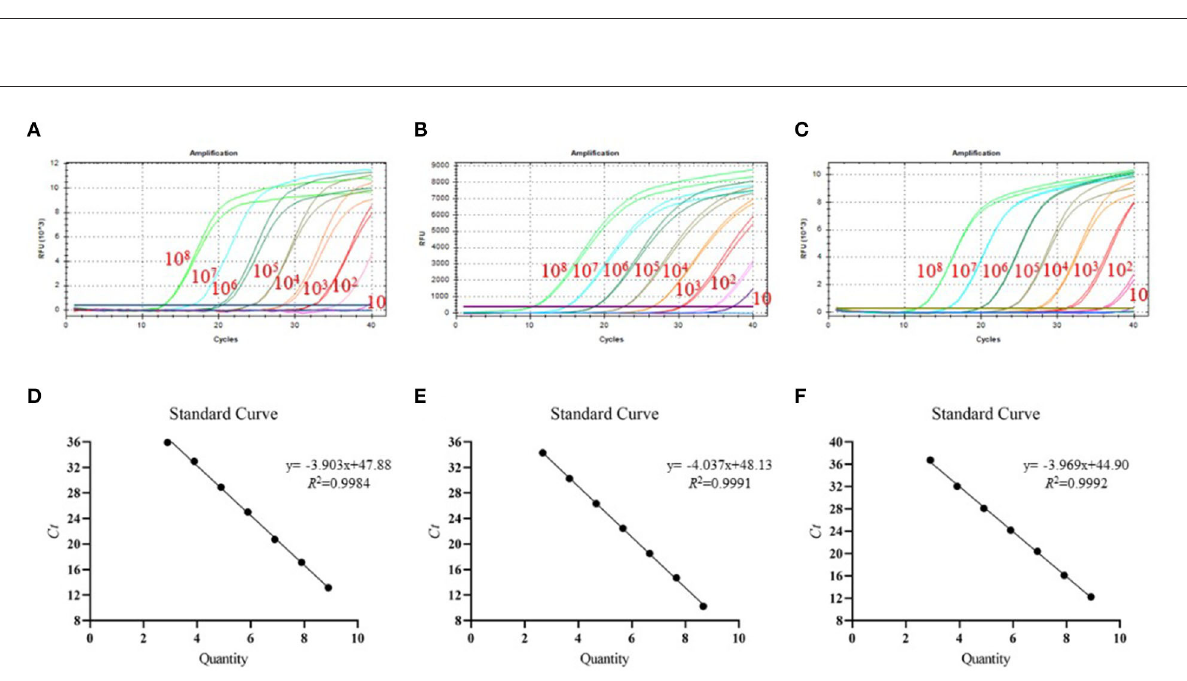
FIGURE2 Detection limit and standard curves of the triplex real-time PCR method developed in this study. (A) Detection limit for B646L; (B) Detection limit for MGF_360-14L; (C) Detection limit for CD2v; (D) Plasmid DNA standard curve for B646L, y = − 3.903x + 47.88, R 2 = 0.9984; (E) Plasmid DNA standard curve for MGF_360-14L, y = − 4.037x + 48.13, R 2 = 0.9991; (F) Plasmid DNA standard curve for CD2v gene, y = − 3.969x + 44.90, R 2 =